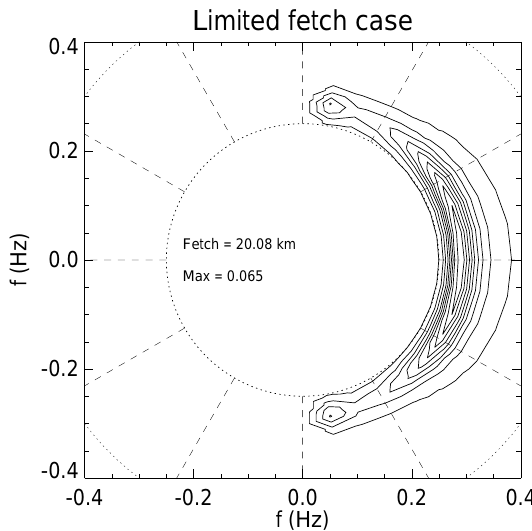
Figure 21. Angular spectrum for the wind speed U = 10ms − 1 lim- ited fetch case.